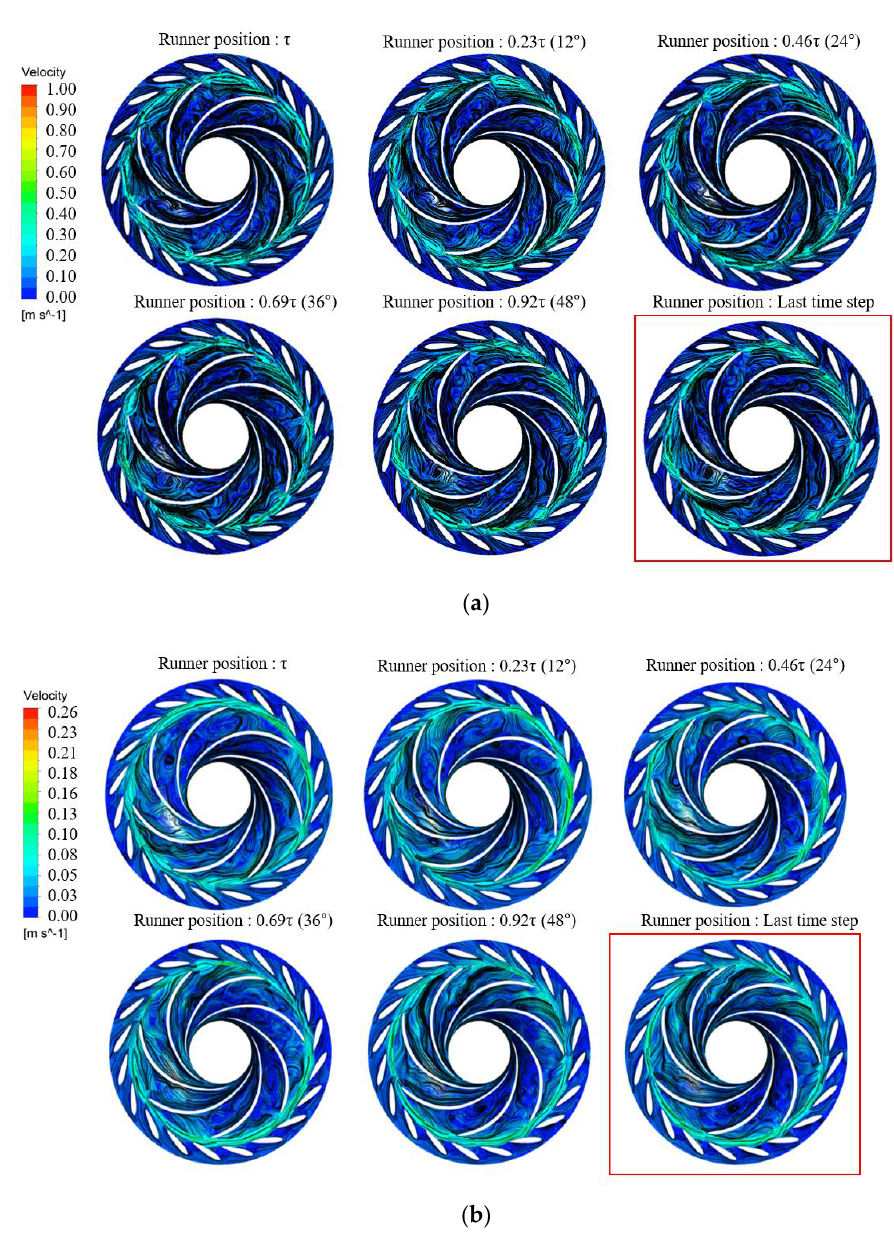
Figure 17. Time history and representative velocity streamlines and contours on the runner mid-span section: ( a ) Full-scale model; ( b ) laboratory-scale model.